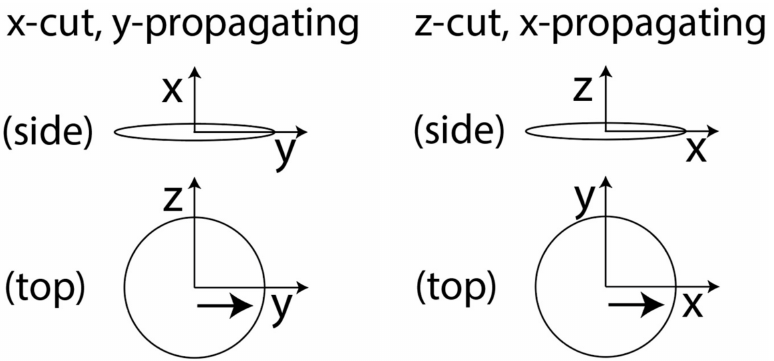
Figure 7. Cut and propagation direction for leaky mode coupling: ( left ) x -cut, y -propagating and ( right ) z-cut,